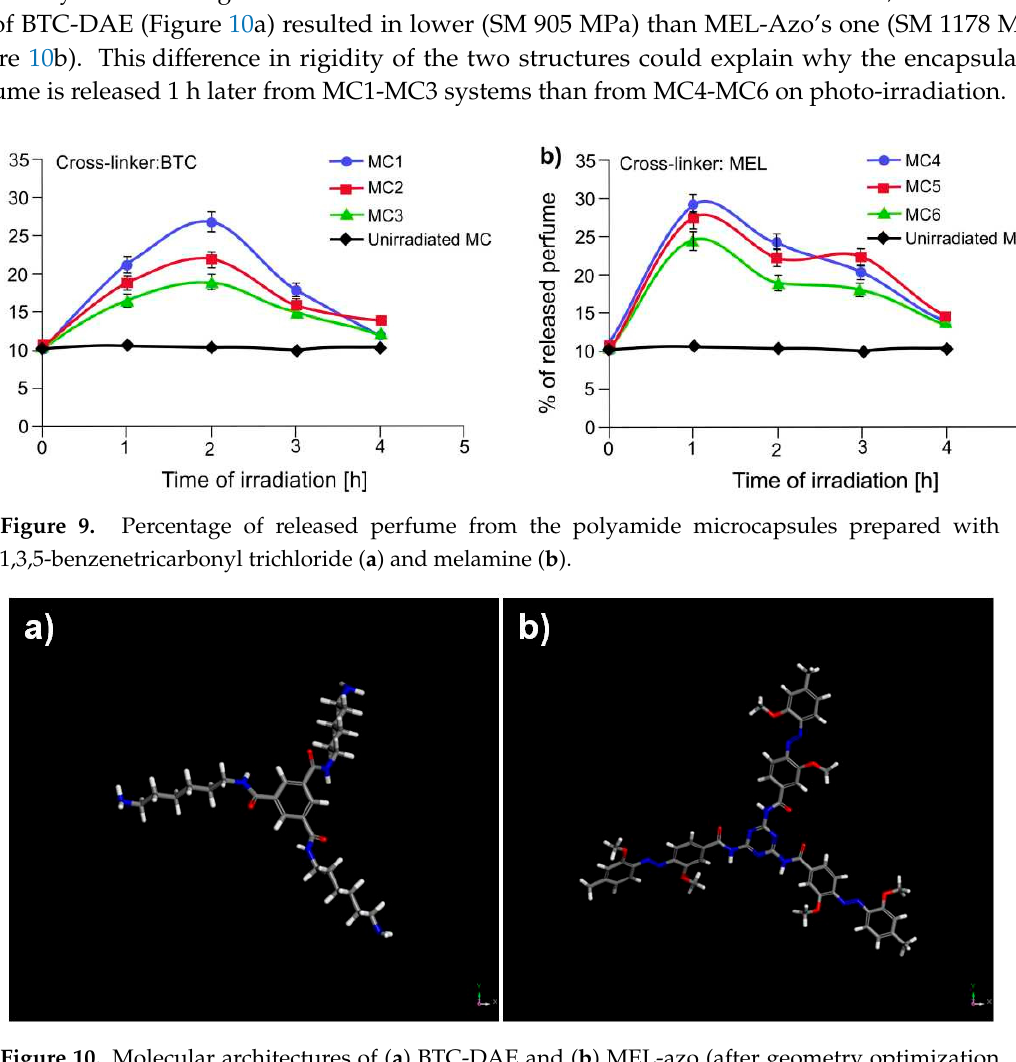
Figure 10. Molecular architectures of ( a ) BTC-DAE and ( b ) MEL-azo (after geometry optimization studies by DMol3 and Vamp modules) incorporated in microcapsule walls.